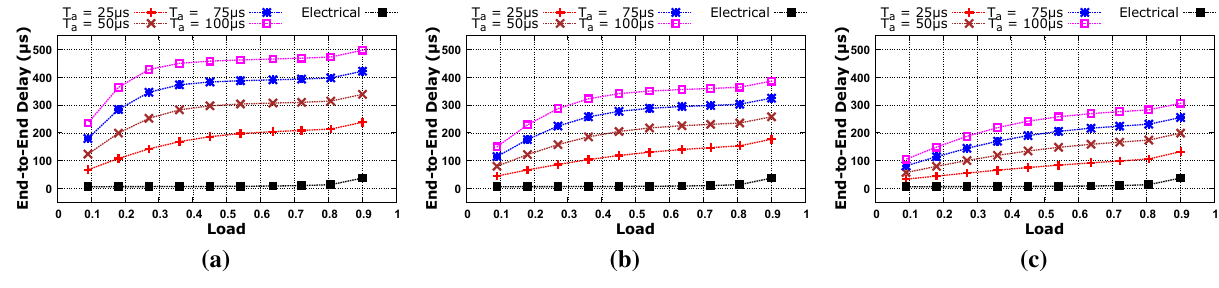
Figure 4. Average end-to-end latency with different parameters of traffic aggregation and with respect to different network over-subscription for low diversity traffic, i.e. , topological degree of communication (TDC) = 1. ( a ) Fully Subscribed Network; ( b ) 2:1 Over-subscribed Network; ( c ) 4:1 Over-subscribed